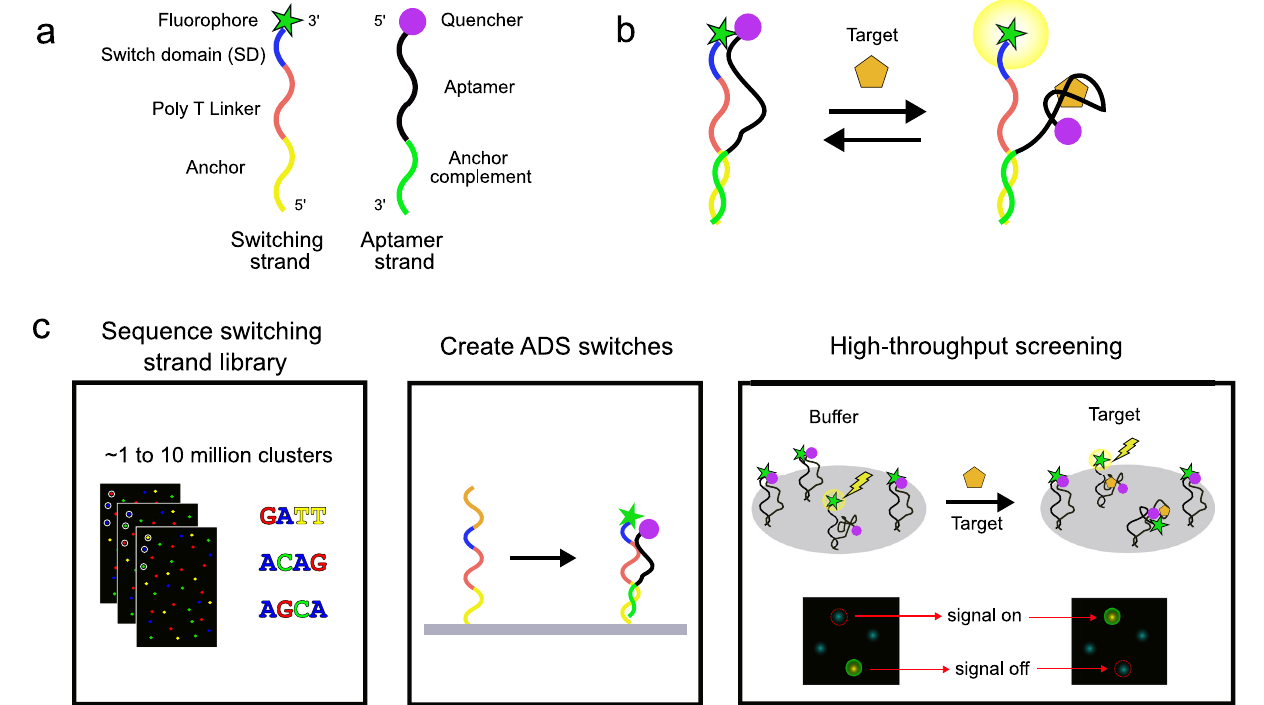
Fig. 1 | Overview of the ADS construct and the high-throughput screening processusedtoconvertknownaptamerstomolecularswitches.a Designofthe fl uorophore-labeled switching strand and quencher-labeled aptamer strand. b Target-inducedconformationalchangesintheADSconstructresultinachangein distance between the fl uorophore and quencher, providing an optical readout. c